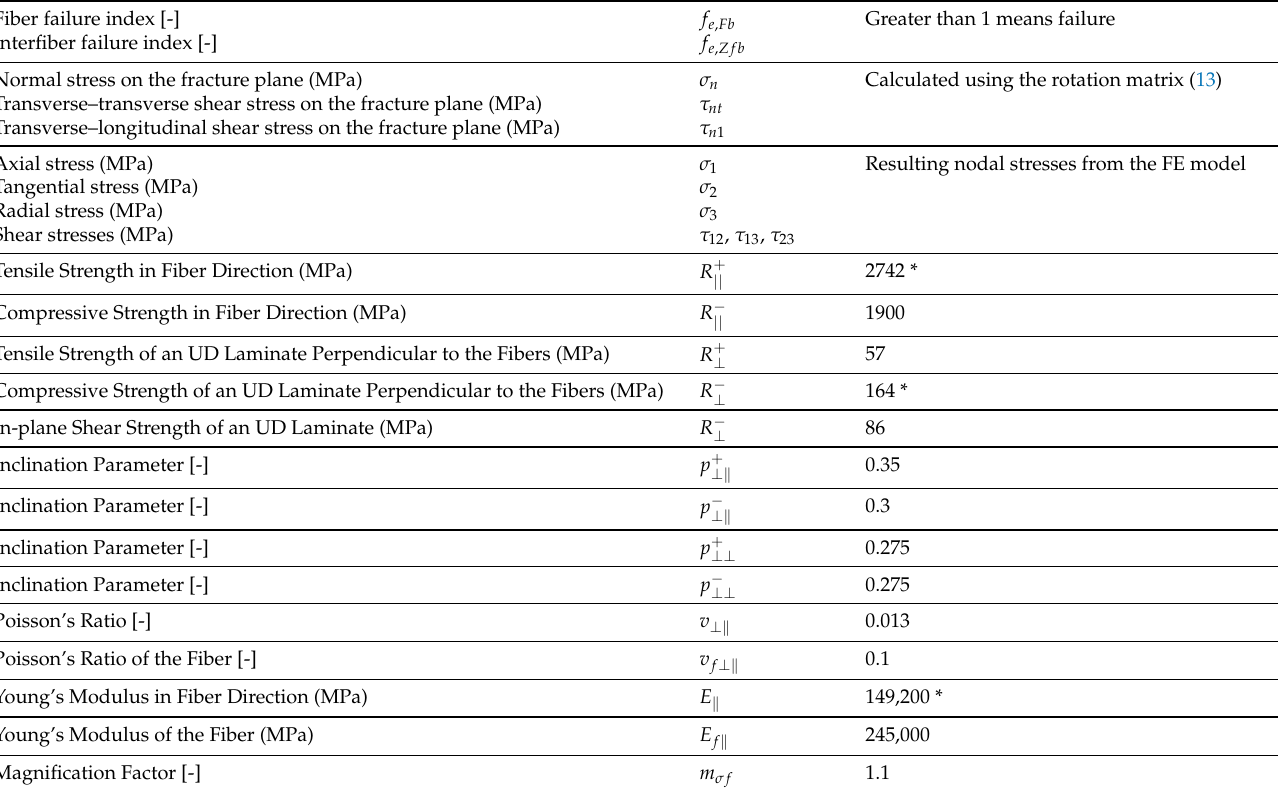
Table A1. Typical values for implementing Puck’s failure criterion (* measured